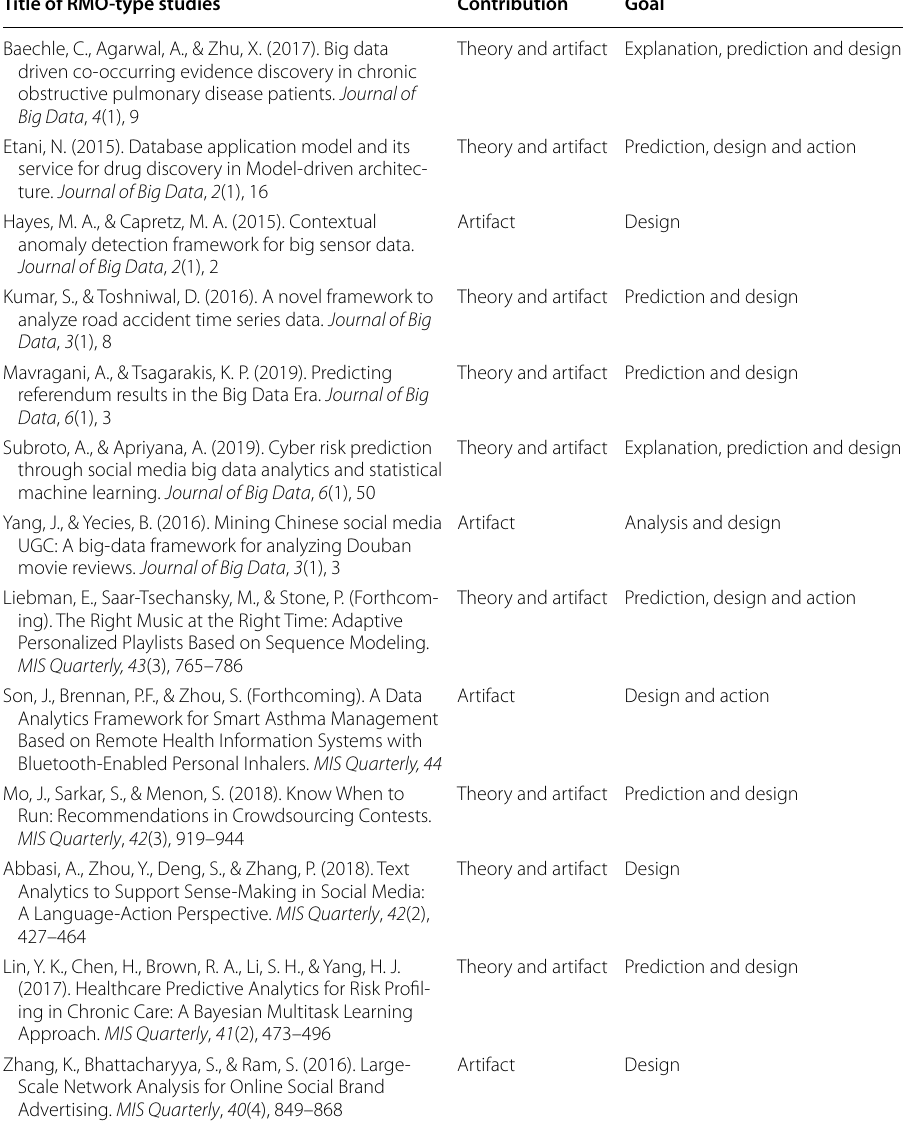
Table 8 Sample of studies using data science as a research method and object of